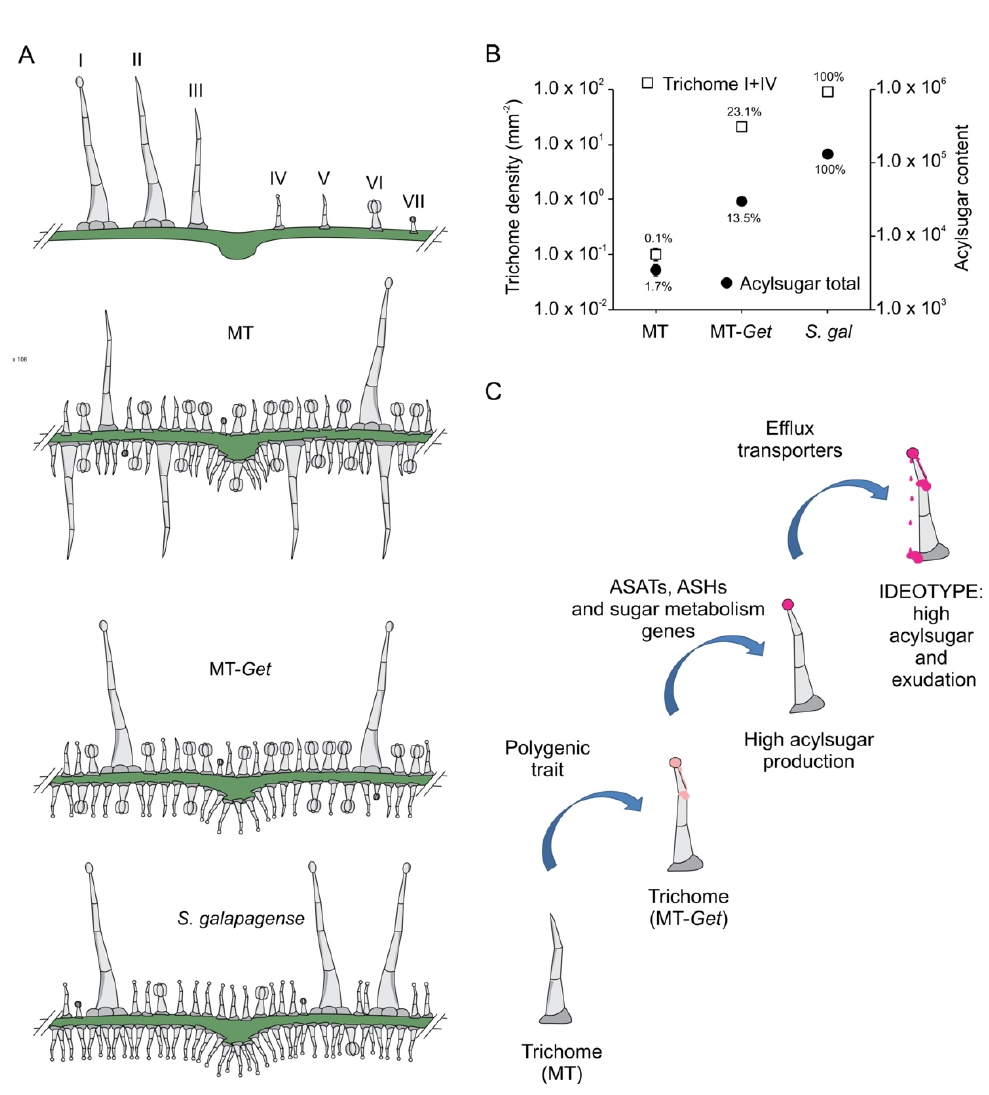
Figure 8. Schematic representation of trichome type distribution in each genotype used in this work ( A ). ( B ) Logarithmic scale representing total trichomes (types I and IV) versus total acylsugar content (signal intensity). ( C ) Sequential steps necessary to obtain broad and durable insect-resistant tomatoes through the high production of acylsugars on tomato leaves. ASAT = acylsugar acyltransferase, ASH = acylsugar hydrolase.